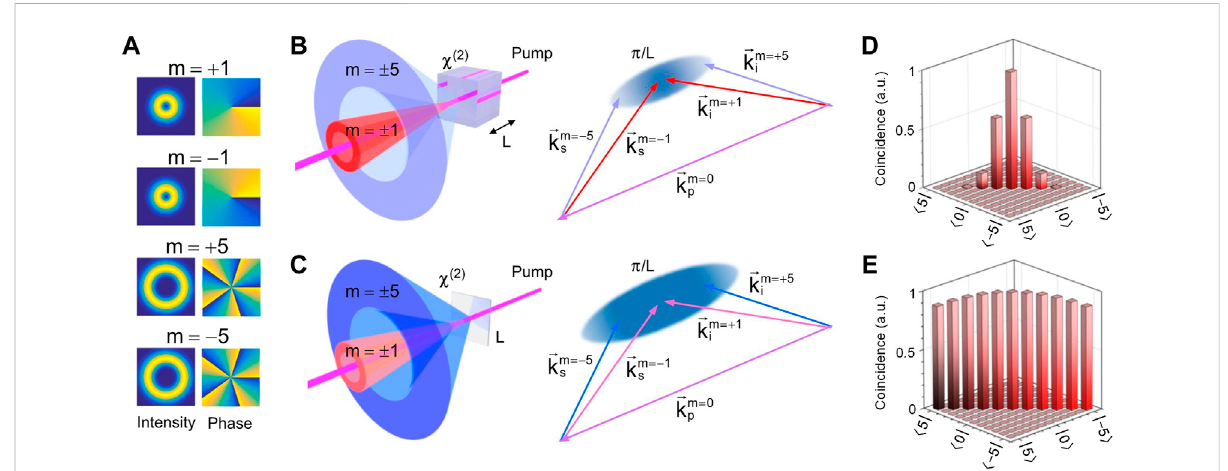
FIGURE 1 (A) TheintensityandphaseforOAM| m |=1and| m |=5.High-dimensional OAMentanglement fromthetype-0SPDCinathick (B) andultrathin (C) nonlinearLNcrystalorthogonaltothepump (D) and (E) isthesimulatedspiralspectrumof11-dimensionalOAMentanglementinthenonlinearLN crystal with length of L = 0.6 mm and L = 6 μ m respectively. The pump is a Gaussian mode m = 0. The coincidences of the different OAM state are normalized by the coincidence at OAM m =